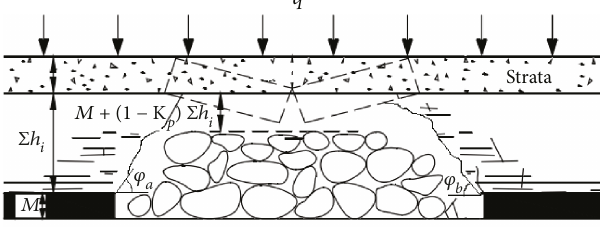
Figure 1: A diagram of fragmentation space under the rock.